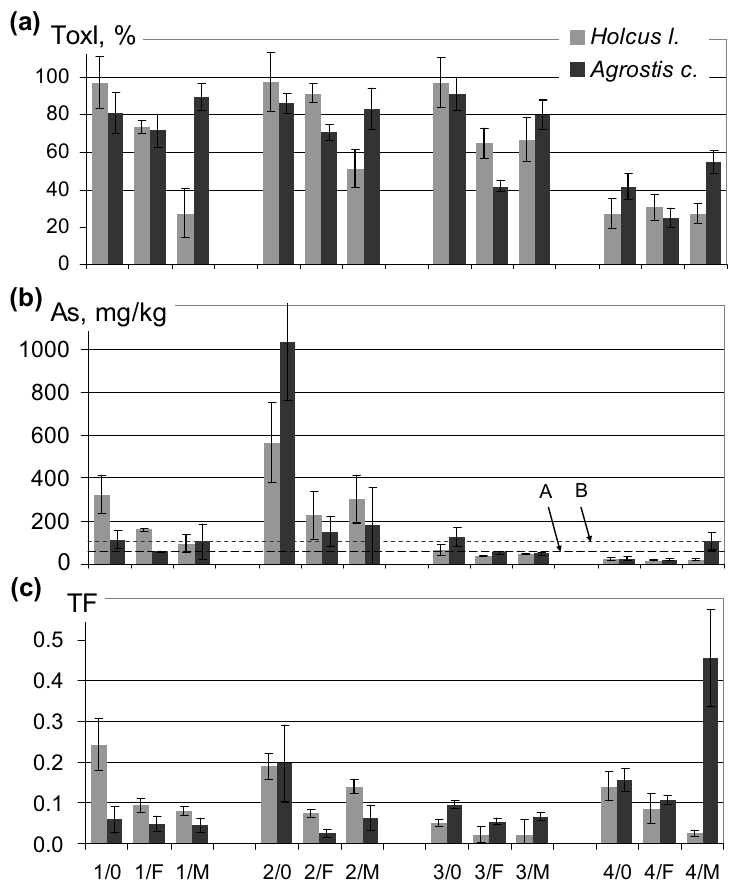
Figure 1. The results of a pot experiment. Parameters that illustrate the growth of grass and As uptake from soils: ( a ) toxicity index ToxI, %, calculated based on the difference between plant biomass in the soil examined and analogously treated control soil; ( b ) As concentration in plant shoots, A and B, stand for maximum As concentrations in the shoots of Holcus lanatus and Agrostis capillaris, respectively, growing in the field; ( c ) As translocation factor. Error bars stand for the least significant difference based on three replicates. Explanations: ToxI—toxicity index; TF—root to shoot translocation factor; 1, 2, 3, 4—soils used in the pot experiment; 0, F, M—various fertilization methods: 0—no fertilization, F—inorganic fertilization, M—fertilization with manure.